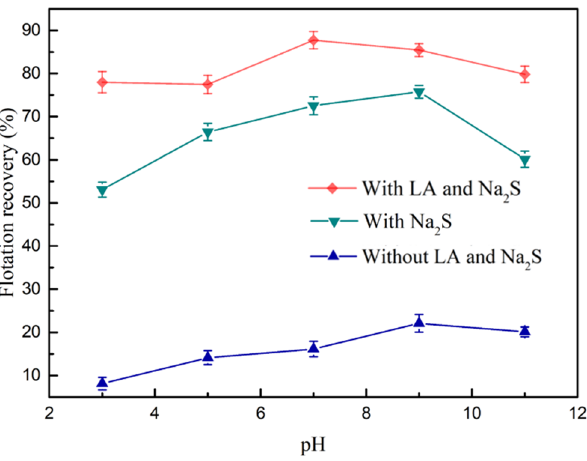
Figure 5. Flotation recovery of malachite as a function of pH ( c (BX) = 1.0 × 10 − 4 mol/L).